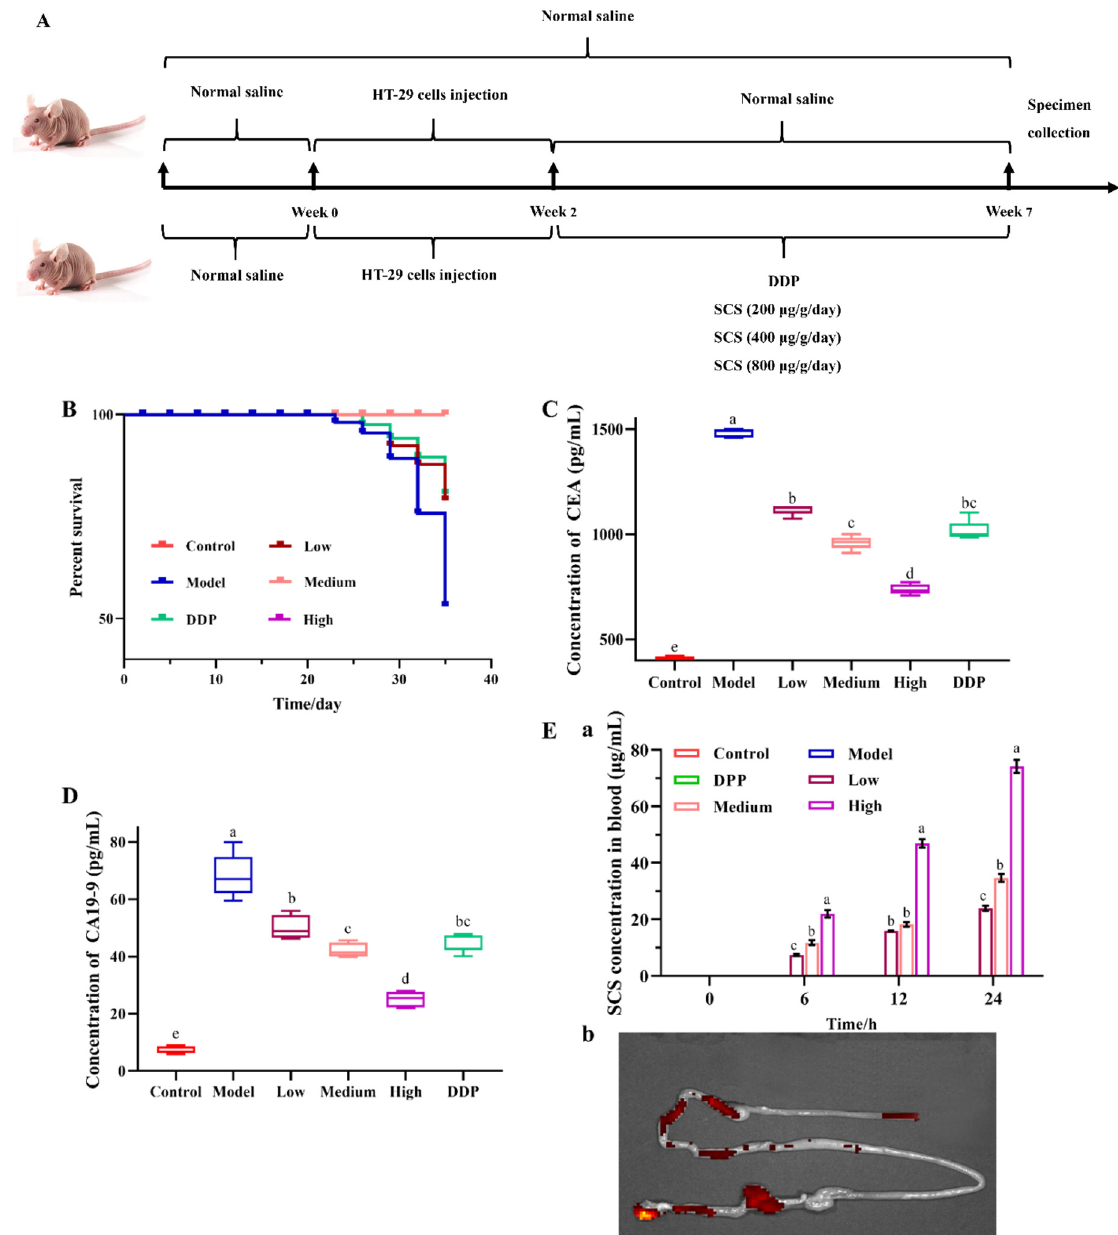
Figure 1. Effect of SCS on HT-29 xenograft tumor mice. Colon cancer HT-29 cells were injected into BALB/c nude mice to develop the CRC model, while the control group was injected with normal saline. After 3 weeks, mice received an intragastric administration of different doses of SCS (spine) and cisplatin (DDP) as a positive control for 4 weeks. Diagram of the experimental design ( A ), survival curve ( B ), expression of tumor biomarkers of CEA( C ) and CA19-9( D ), the content of SCS in blood after oral administration of SCS samples ( Ea ), ex vivo fluorescence images of major organs and tumor dissected from mice at 24 h ( Eb ). Results are expressed as mean ± SEM ( n = 5). Different superscript letters for each column indicate significant differences ( p < 0.05) as compared to every other group.